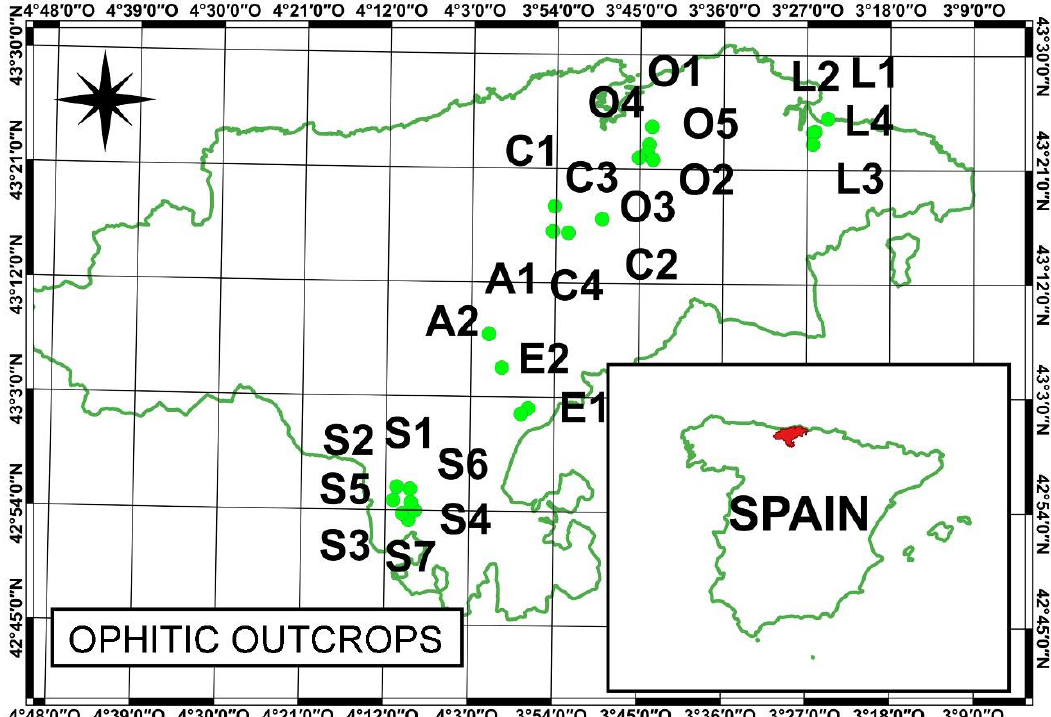
Figure 1. Territorial context of Cantabria in Spain and location of the ophitic outcrops. Area of Laredo: El Canto (L1), Peña Lucía (L2), Colindres (L3) and Limpias (L4). Area of Orejo: Orejo (O1), Solares (O2), Sobremazas (O3), Anaz (O4) and Hermosa (O5). Central Area: San Román (C1), Esles (C2), Sandoñana (C3) and Escobedo (C4). Area of Alsa: Cueto Pando (A1) and the Alsa Reservoir (A2). Area of Ebro: Ebro Reservoir (E1) and La Población (E2). South Area: San Martín de Hoyos (S1), Olea (S2), Castrillo del Haya (S3), Rebolledo (S4), Camesa (S5), Matarrepudio (S6) and El Haya (S7).